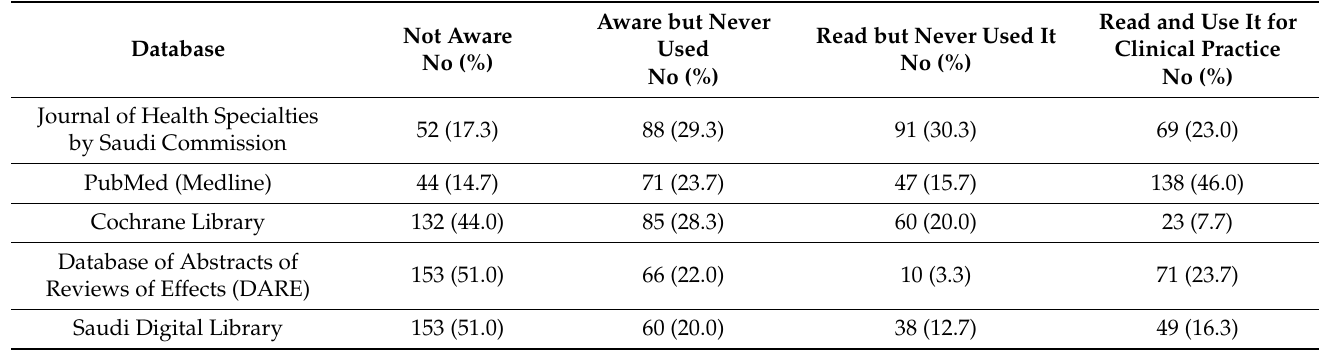
Table 2. Knowledge and awareness regarding relevant EBM databases (n = 300).